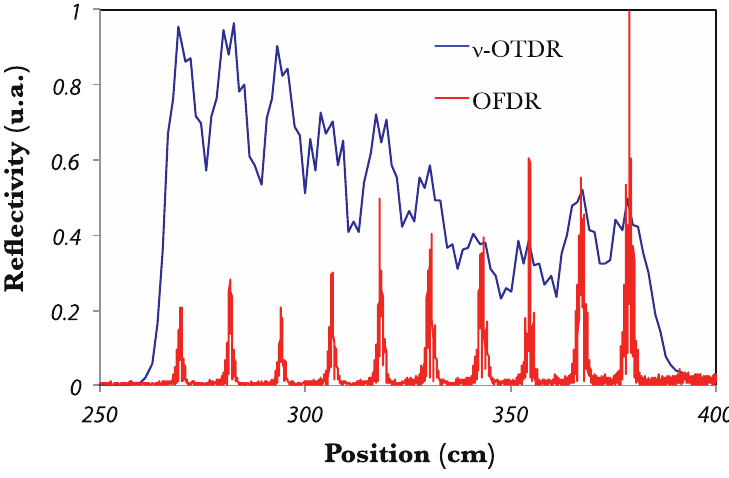
Figure 7. OFDR trace for 10 identical FBGs cascaded in an optical fiber embedded into a composite material fabric and corresponding photon-counting OTDR